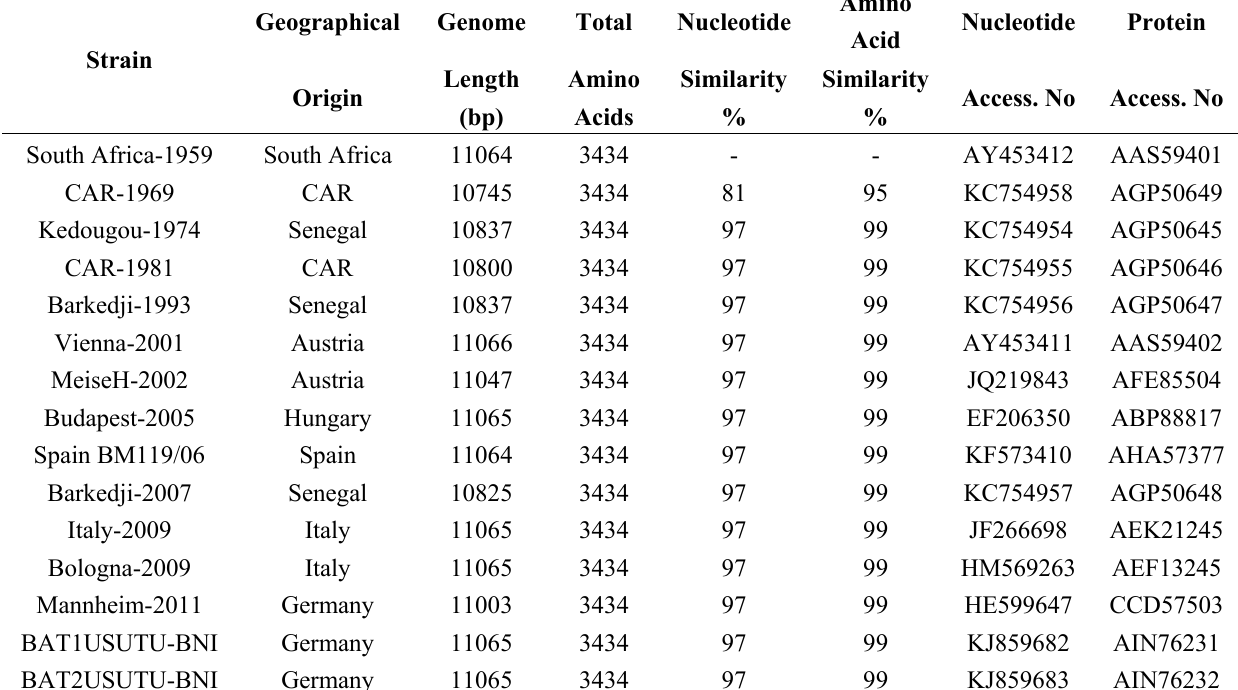
Amino Nucleotide